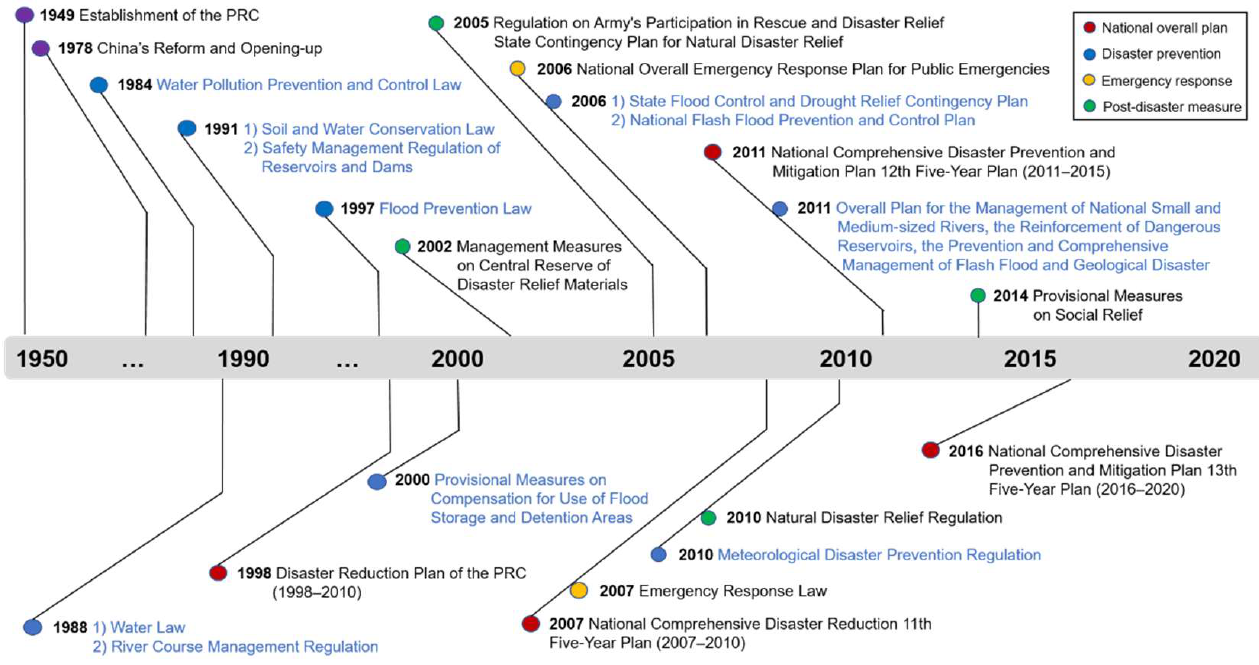
Figure 5. Important policies, laws and regulations on flood-related disaster risk management in China during 1949–2020.